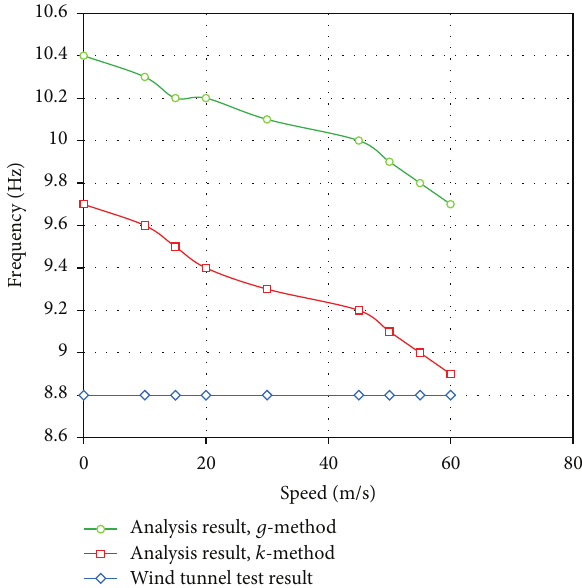
Figure 10: Flutter frequency comparison between test and analysis result versus